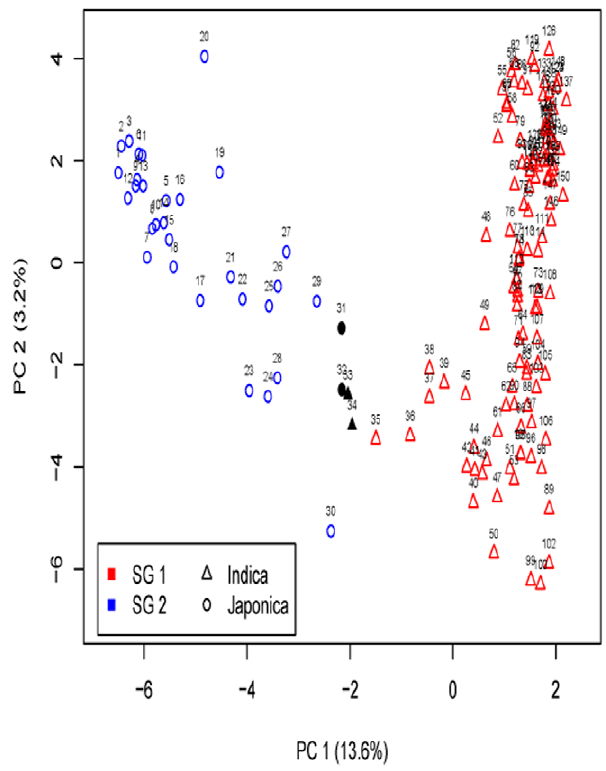
Figure 2. Principal component analysis on SSR genotypes of the entire population. PC 1 and PC 2 refer to the first and second principal components, respectively. The numbers in parentheses refer to the proportion of variance explained by the corresponding axes. Symbols identify the germplasm types and colors the STRUCTURE and MCLUST subgroups. SG 1 and SG 2 are the two subgroups identified by both MCLUST on SSR marker genotypes and STRUCTURE assigned with the max membership probability. The black dots are the varieties with different assignment by MCLUST and STRUCTURE. I and J are indica and japonica rice identified by Cheng’s index.